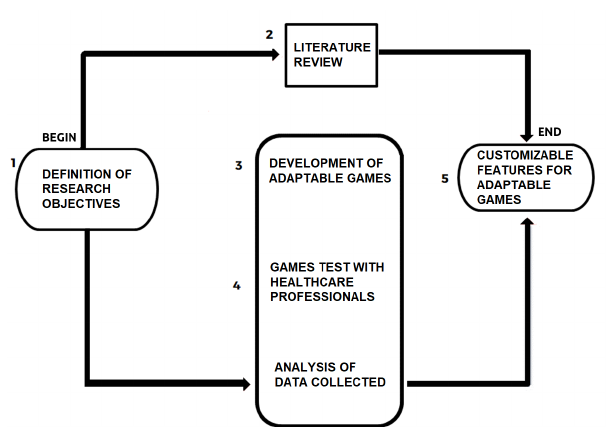
Figure 1. Research Methodology